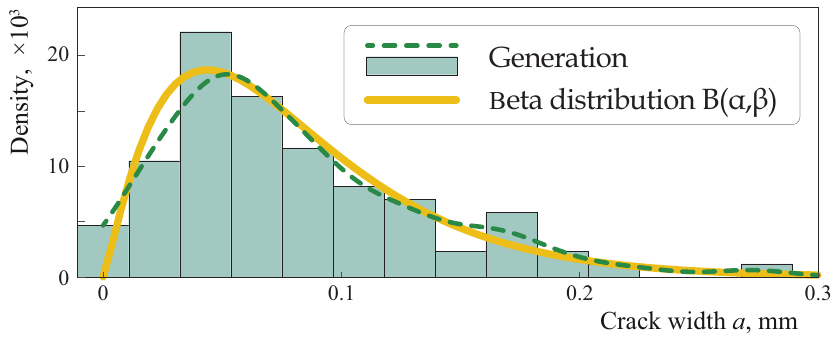
Figure 5. Histogram of crack width a